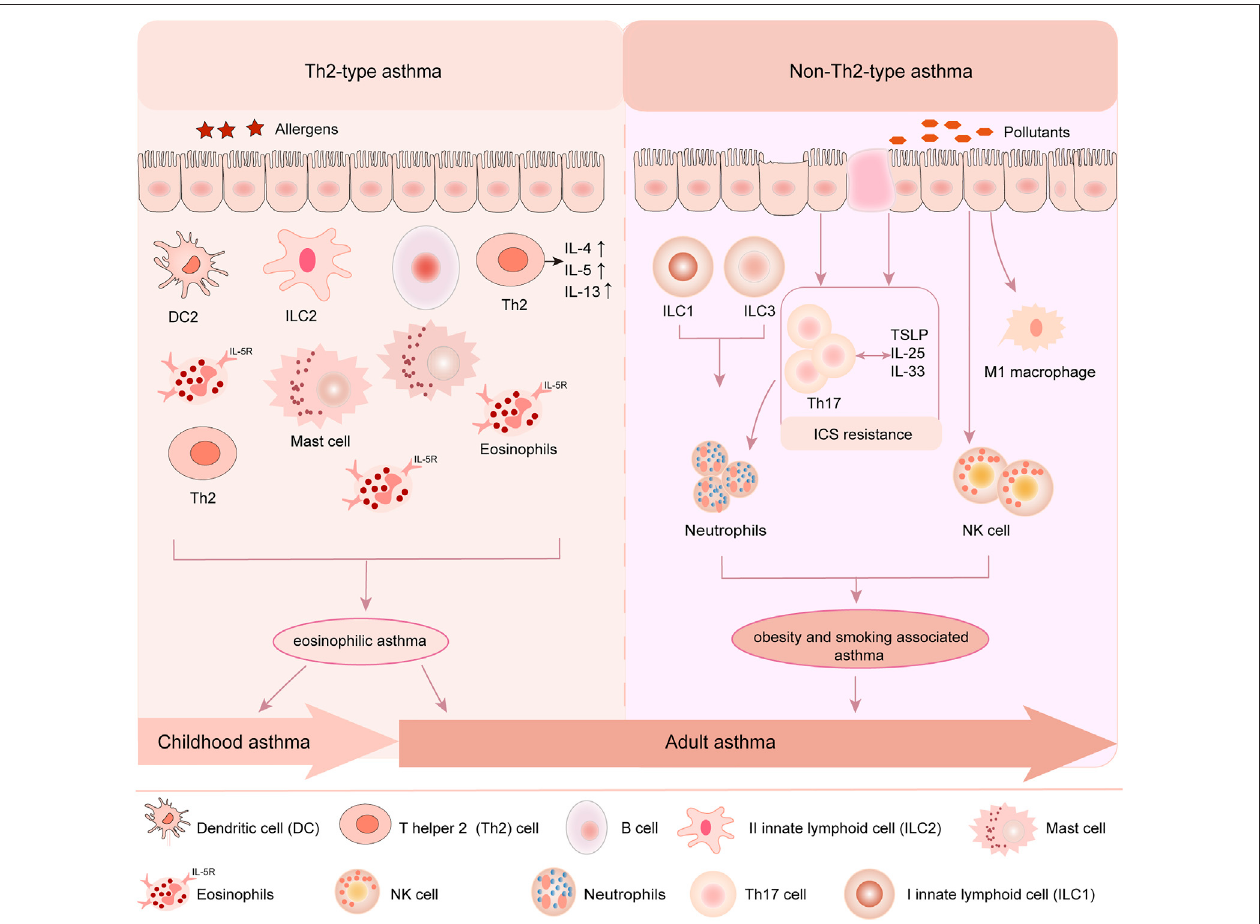
FIGURE 1 | Childhood asthma and adult asthma phenotypes. Childhood asthma and adult asthma are crossed and different in phenotypes. In children, Th2-type asthma is the main common type. Allergen stimulates the recruitment of in fl ammatory cells such as eosinophils, the proliferation and activation of immune cells such as mast cells and DCs, and induces the injury of airway epithelial cells, which lead to the release of in fl ammatory factors and Th2 cytokines, such as IL4, IL5 and IL13. In adult, both Th2-type and non-Th2-type asthmaaretwocommon types. Uponpollutantsstimulation,type Iinnate lymphoidcells (ILC1)andtype III innatelymphoid cells activation (ILC3) activate neutrophils and airway epithelial cells to drive the proliferation of Th17 cells which mediates in turn neutrophil recruitment. Pollutants also contribute to M1 macrophage and NK cell recruitment to the airways, resulting in non-Th2-type asthma in adult.